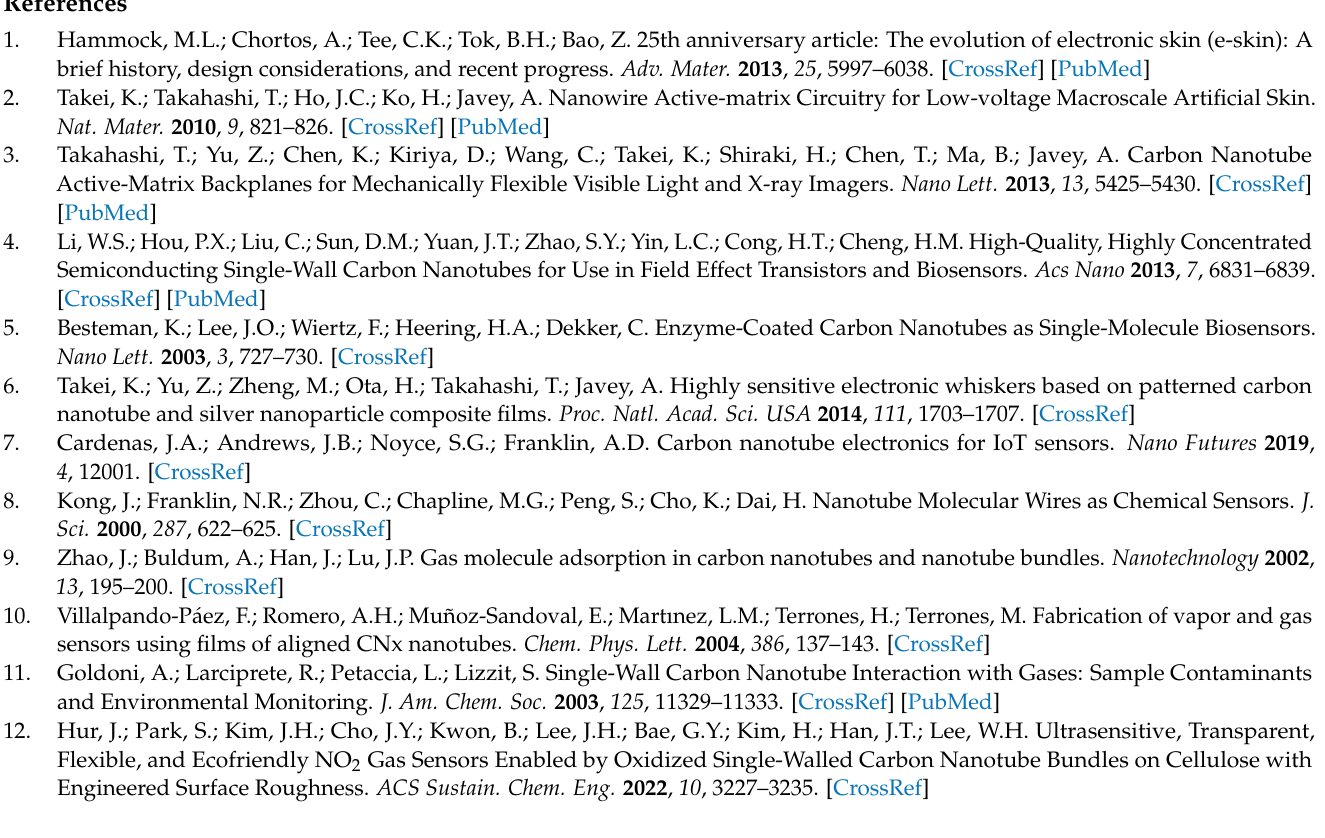
flexible and transparent SWCNT film loaded on a filter; Figure S2: Optical images of the fabricated N-SWCNT film-based flexible sensors; Figure S3: SEM images of (a) pure SWCNT and (b) F-SWCNT films; Figure S4: TEM images of (a) pure SWCNT and (b) F-SWCNT films; Figure S5: EDS elemental (C, N, and O) maps of a SWCNT bundle; Figure S6: XPS spectra of N-SWCNT films with different doped N contents; Figure S7: Sensing performance of pure SWCNTs upon exposure to NO 2 with different concentrations; Figure S8: Responsivity of the 9.8-sensor exposed to 0.5 ppm NO 2 ; Figure S9: (a) The sensor was bent into a roll with a radius of curvature of 2 mm for 30 times. (b,c) Performance measurement of the sensor after 30 cycles of bending; Table S1: Parameters of the fluorination process and the F-doping contents; Table S2: The contents of pyridinic N (N-6), pyrrolic N (N-5) and graphitic N (N-Q) in N-SWCNT samples calculated from their deconvoluted peak